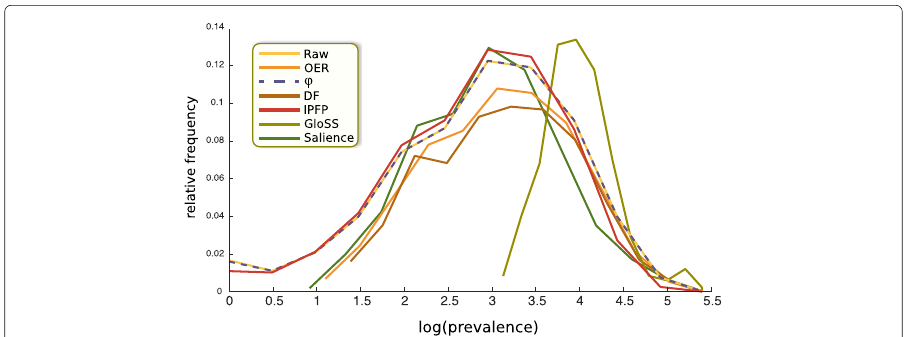
Fig. 4 Visualizing Prevalences. The distribution of the ln ( prevalence ) of the diseases in different